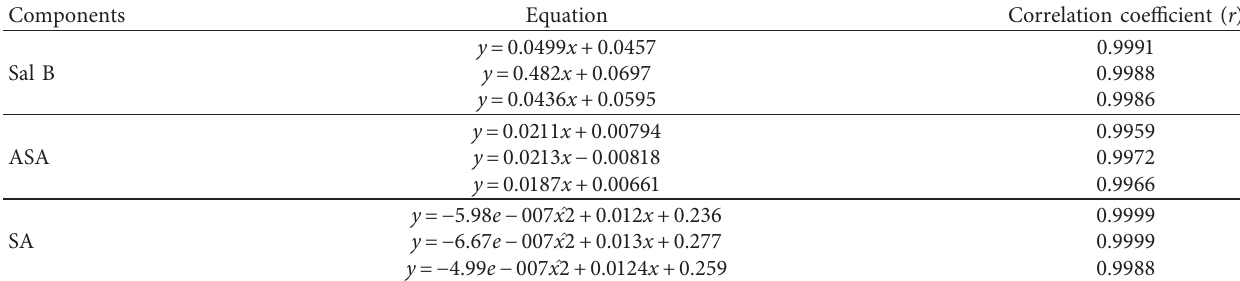
Table 2: Calibration curves and correlation coefficients of Sal B, ASA, and